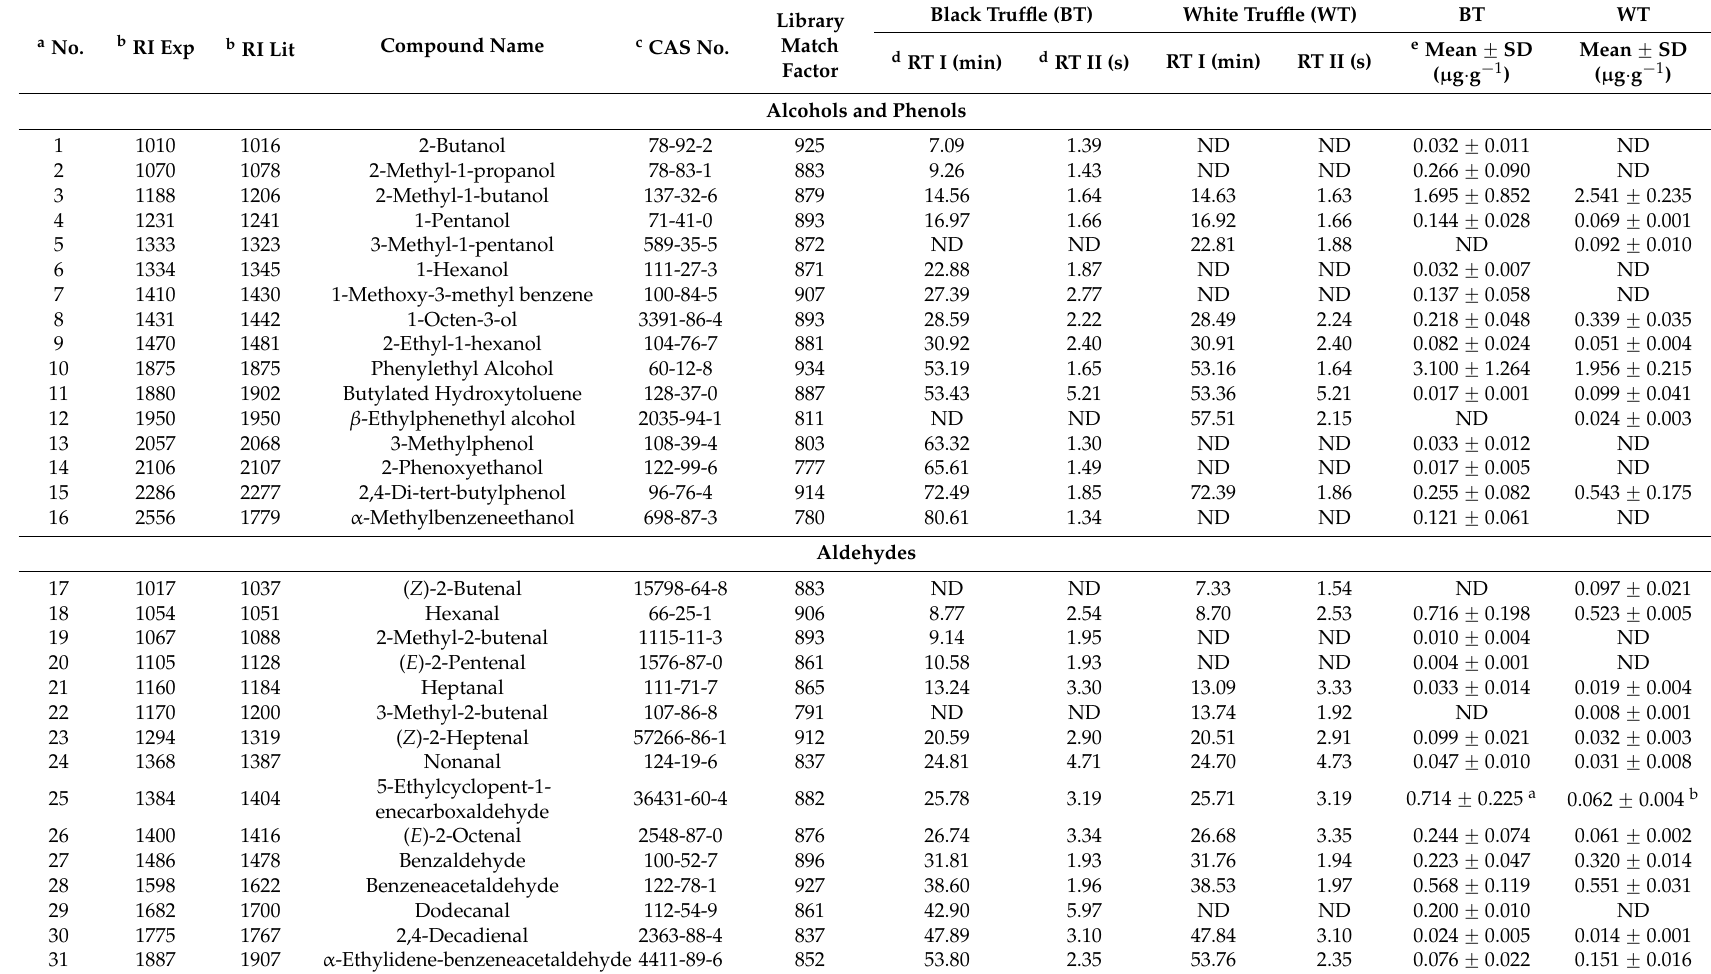
Table 1. Volatile compounds identified in black truffle (BT) and white truffle (WT) via direct solvent extraction/solvent-assisted flavor evaporation (DSE-SAFE) combined with comprehensive two-dimensional gas chromatography (GC ˆ GC) high resolution time-of-flight mass spectrometry (HR-TOF/MS).